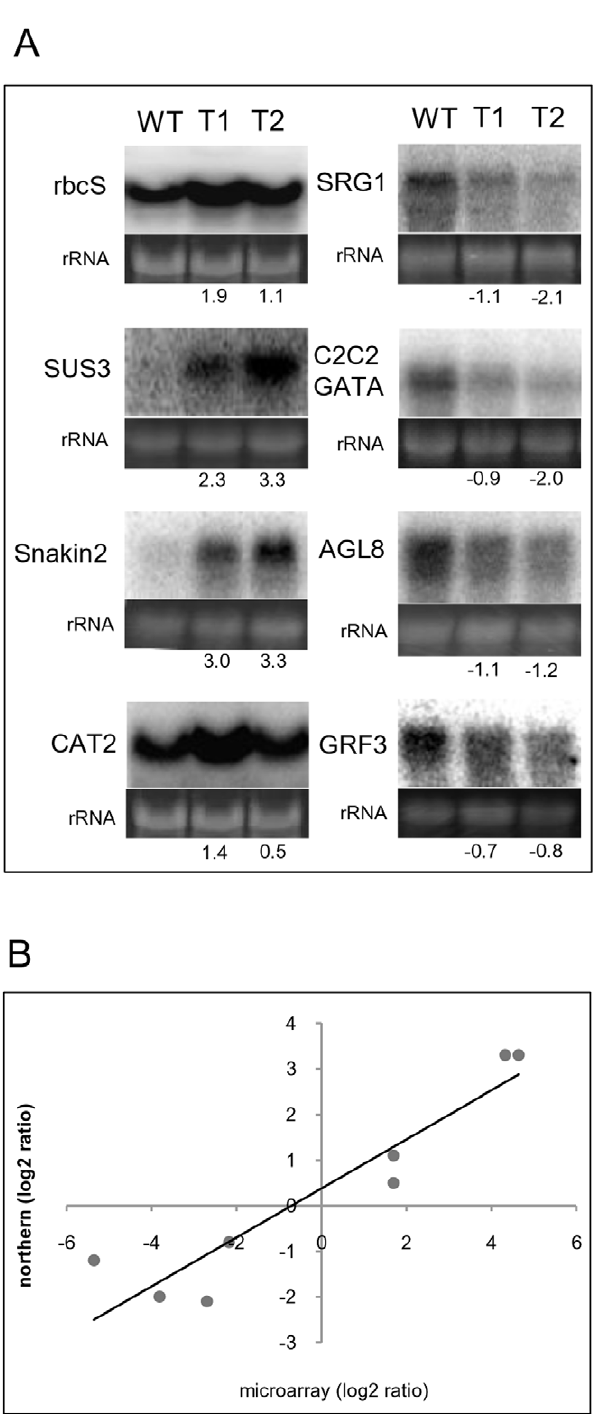
Figure 1. Validation of microarray results. A) RNA gel blot analysis of selected genes. Phosphorimage analysis was used to quantify the intensity of hybridisation. The expression ratios between T1, T2 and wild-type plants are shown below the lanes as log2 values. Ethidium bromide-stained rRNA bands are shown as loading controls. WT, wild- type; T1, T2, two independent TPS1 -transgenic lines. B) Correlation between microarray and northern results in T2/wild-type comparison. A statistically significant correlation (r=0.9369, p=2.376e 2 06 ) was ob- tained for all genes tested.